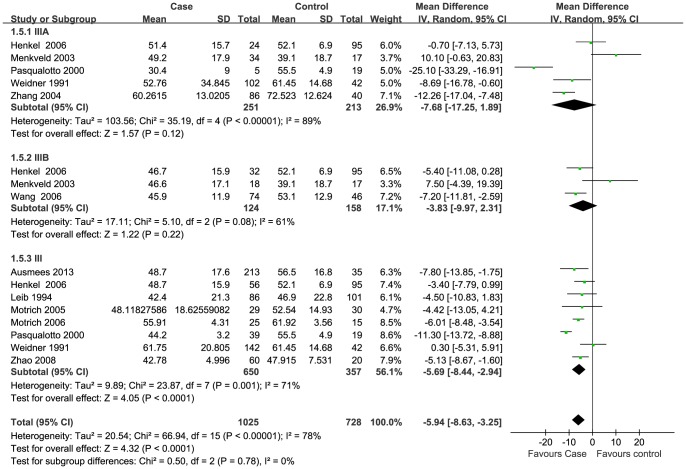
Forest plot showing the meta-analysis outcomes of the effect of CP/CPPS on sperm progressive motility.